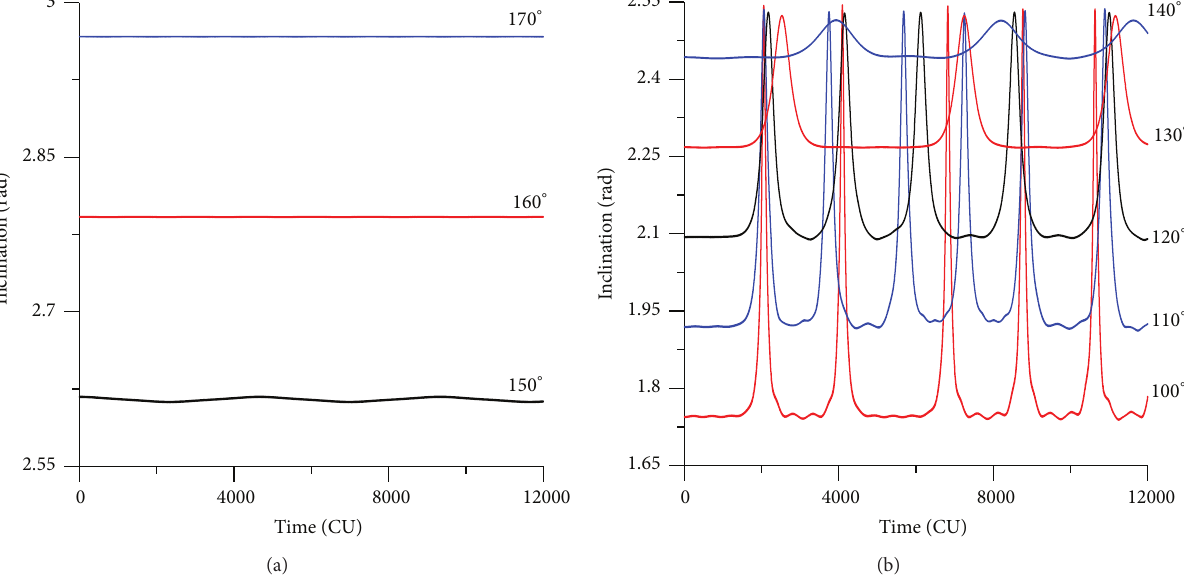
Figure 9: Evolution of the inclination for circular and retrograde orbits (exact model). The initial conditions are a = 0.341 canonical units, e (0) = 0, M 0 (0) = 0, 𝜔 (0) = 0, and Ω (0) =